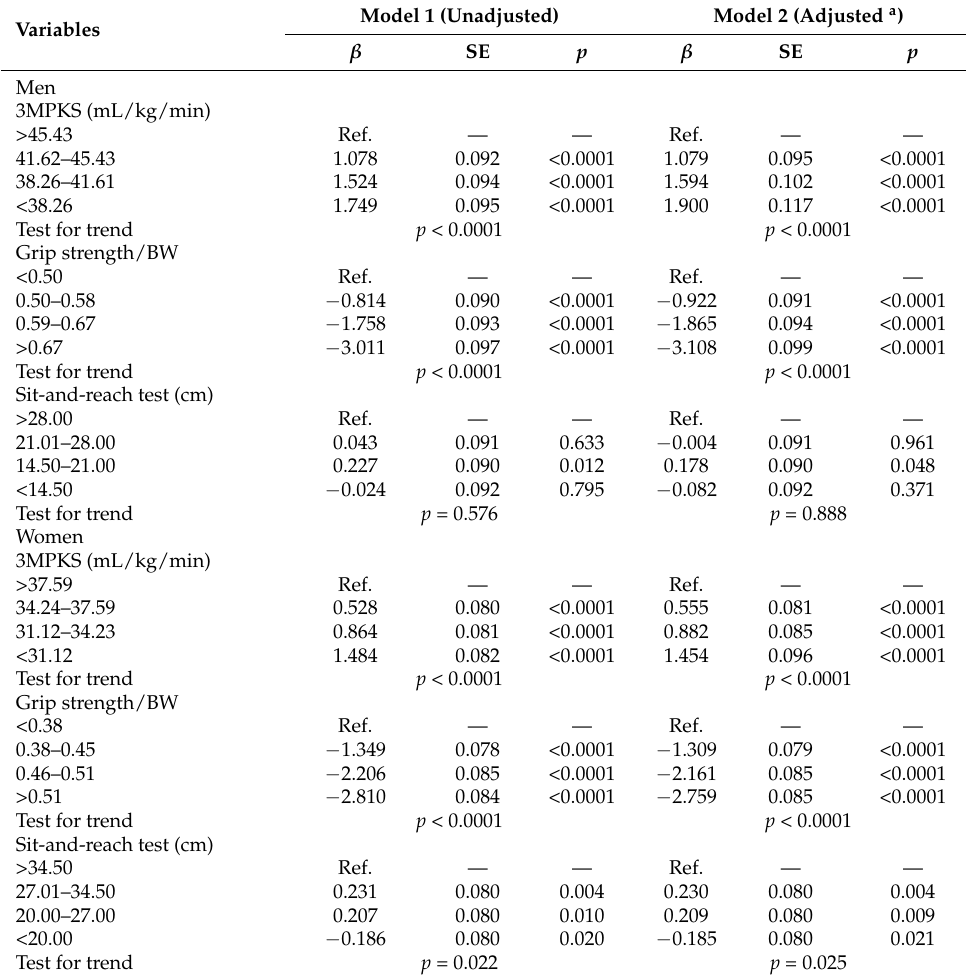
Table 4. Regression coefficients for predicting BMI using different quartiles of scientific physical fitness